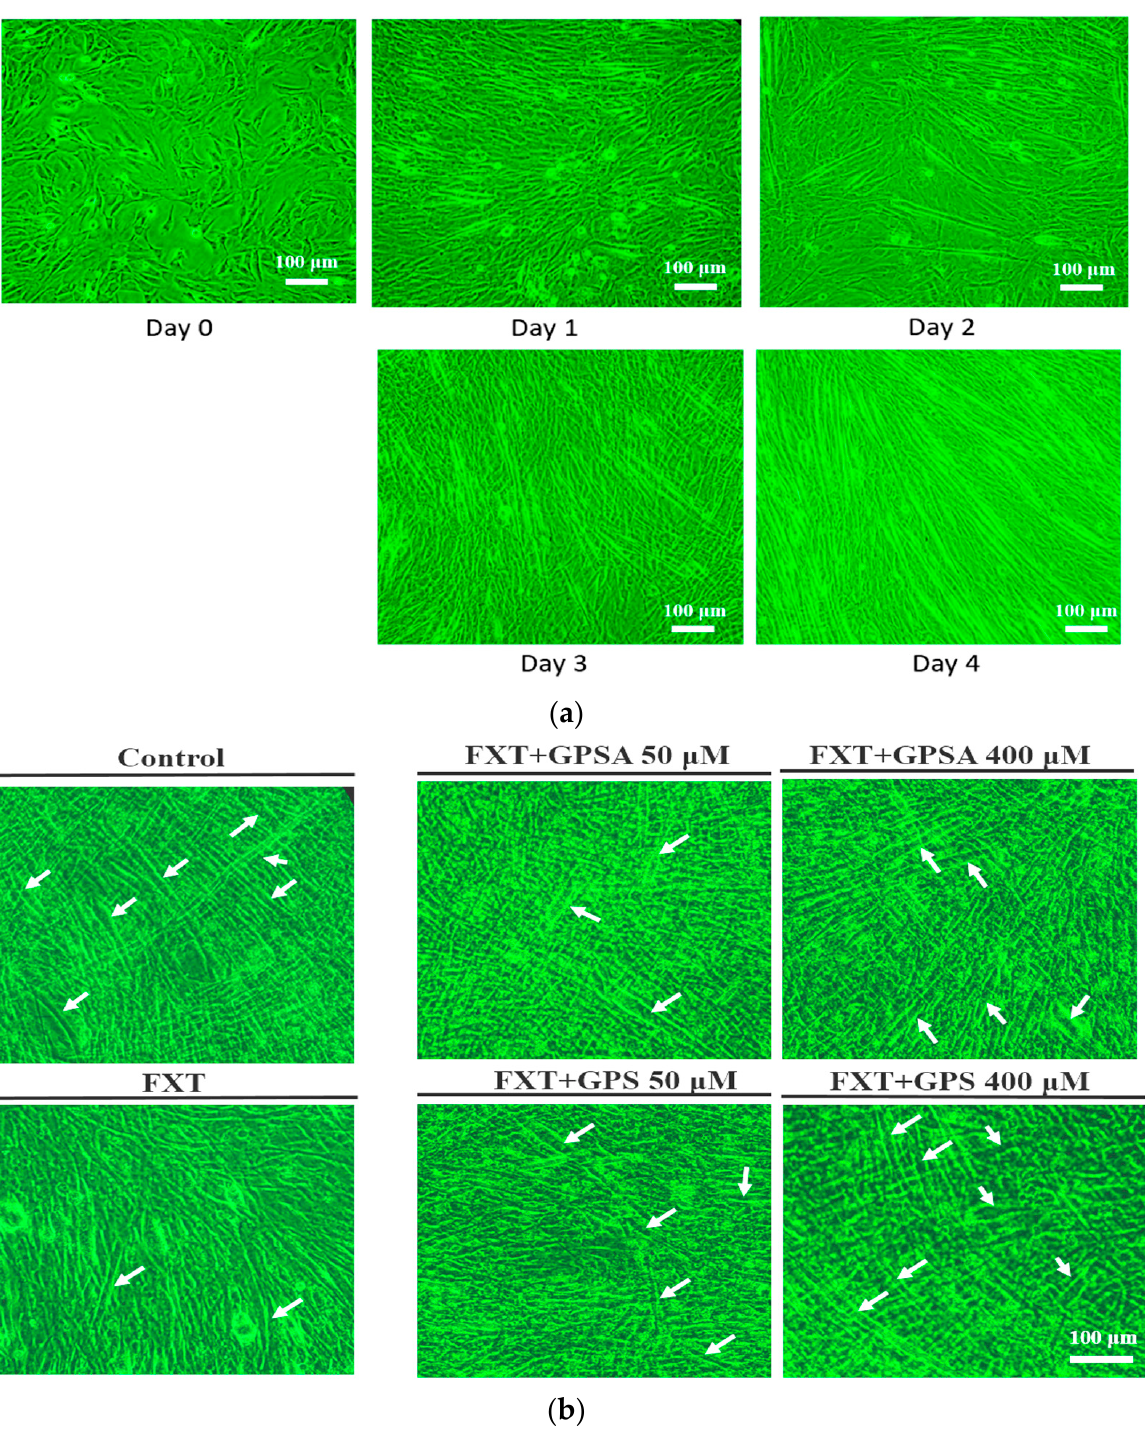
Figure 2. Effect of GPSA and GPS on the differentiation of FXT-treated C2C12 muscle cells. ( a ) Phase-contrast images of the undifferentiated (day 0) and the differentiated (day 1–day 4) C2C12 muscle cells. ( b ) C2C12 cells were differentiated in 6-well plates for 4 days and then treated with PBS (vehicle control), FXT (20 µ M), GPSA (50 µ M and 400 µ M), and GPS (50 µ M and 400 µ M) for 48 h, respectively. Myotubes were examined with a phase-contrast light microscope (Olympus CKX41). Original magnification, × 200. Scale bar indicates 100 µ m. The arrow signs indicate the survival myotubes.